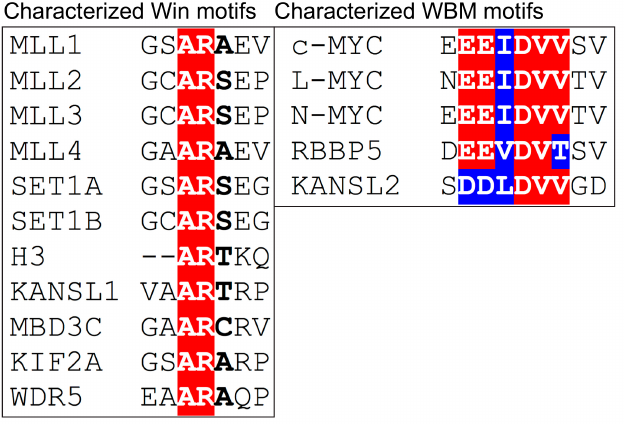
Figure 4. The canonical function of WDR5 is as a core component of the SET1/MLL histone methyltransferase complexes. WDR5 functions to scaffold six distinct histone methyltransferase complexes, which catalyze the epigenetic marks of mono-, di-, or tri-methylation at lysine 4 of the peptide tails of histone H3. Two binding sites on WDR5 are required for efficient scaffolding of these complexes. These six complexes differ in the identity of the SET1/MLL protein they carry.